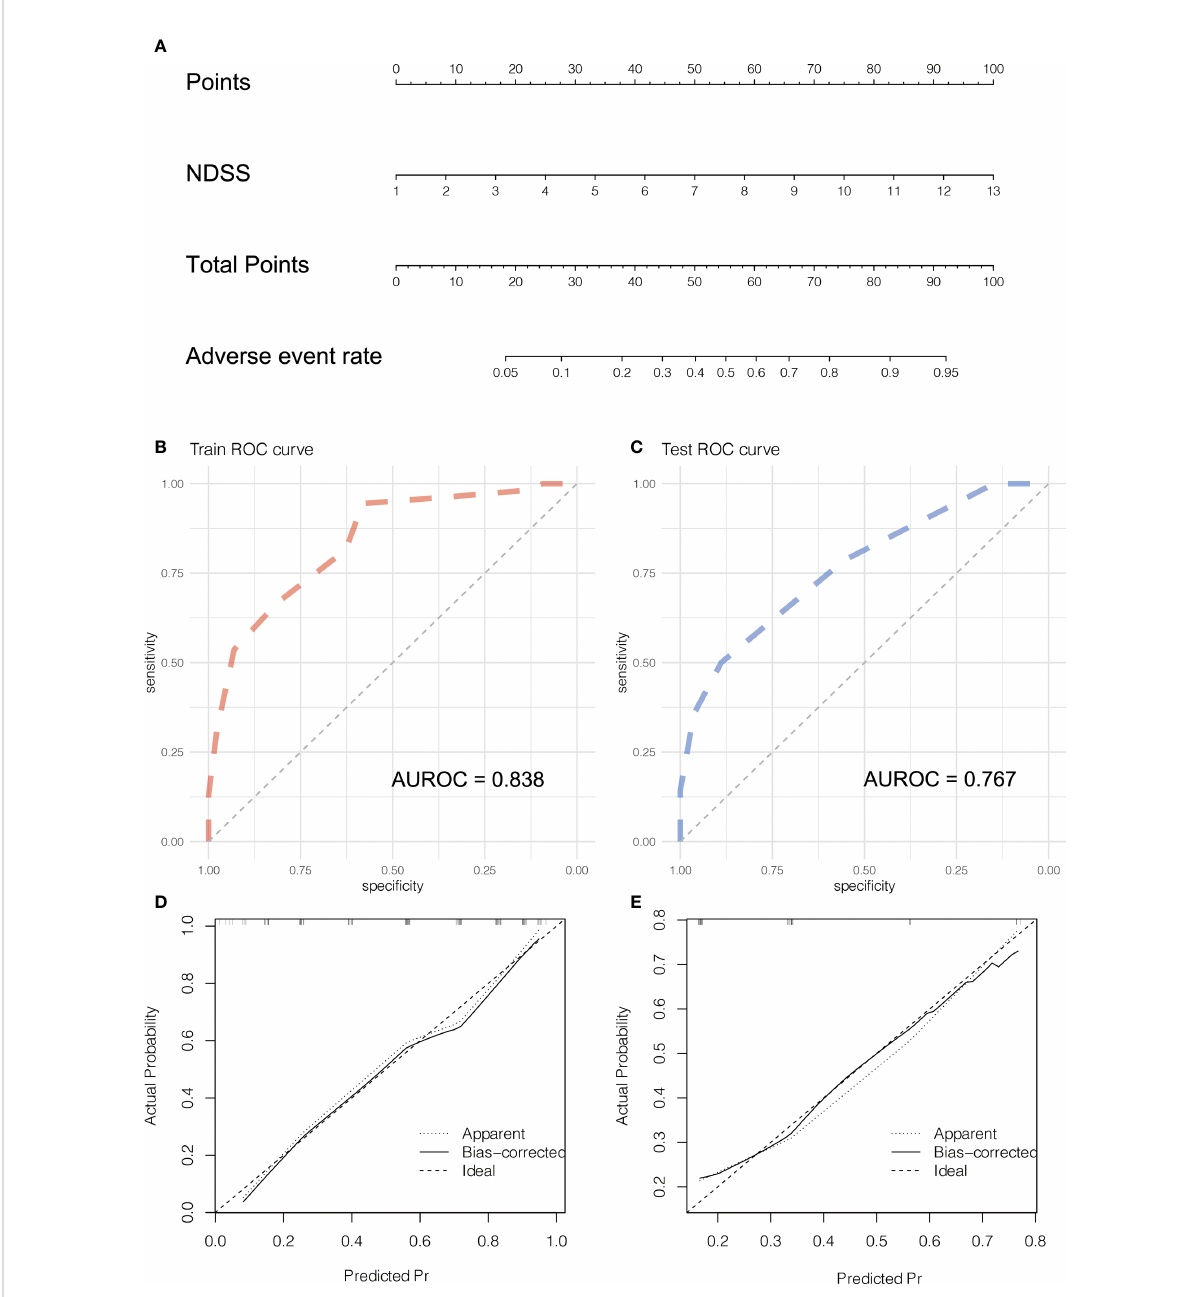
FIGURE 7 Development and validation the Nomogram of adverse event. The nomogram (A) of adverse event. The ROC curve of the nomogram in training (B) and testing (C) cohort. The calibration plots of the nomogram in training (D) and testing (E)